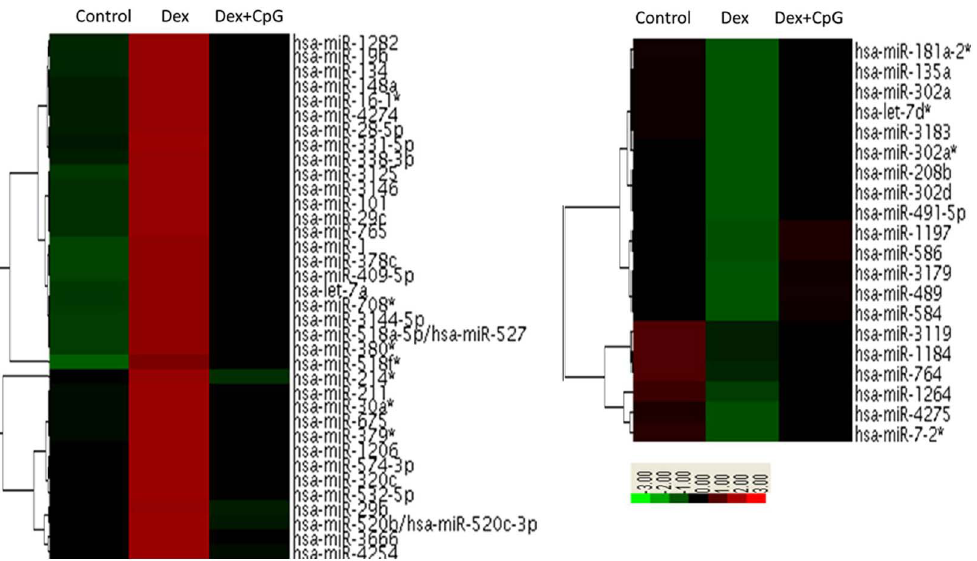
Figure 1. miRNAs are involved in CpG-inhibited Dex-induced pDC apoptosis. miRNA array analysis of miRNA expression in pDCs after stimulation with Dex alone or in combination with CpG. The expression levels of miRNAs that were altered by greater than a single fold are presented.